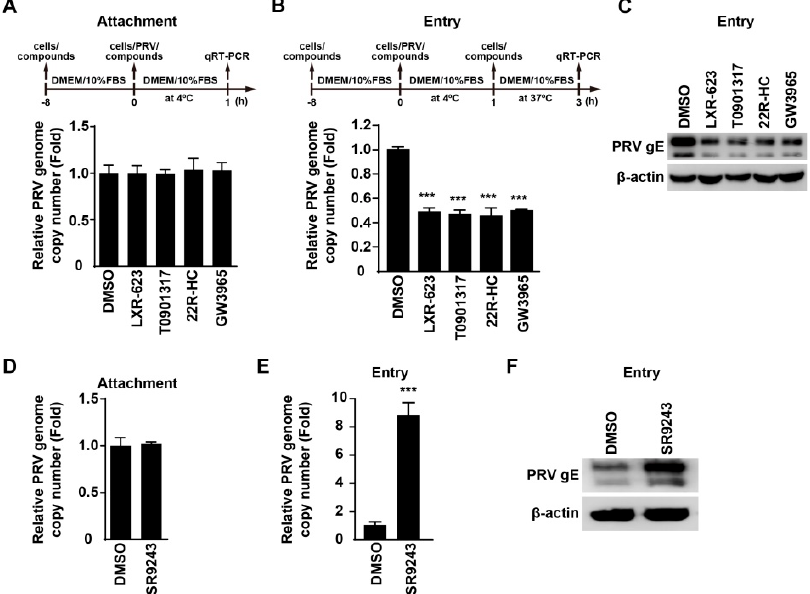
Figure 4. Activation of LXR inhibits PRV entry. ( A ) PK-15 cells were pretreated with DMSO, LXR-623 (6 µ M), T0901317 (6 µ M), 22R-HC (6 µ M) and GW3965 (3 µ M) for 8 h at 37 ◦ C. Cells were incubated with PRV-QXX (MOI = 0.1) combined with DMSO, LXR-623 (6 µ M), T0901317 (6 µ M), 22R-HC (6 µ M), and GW3965 (3 µ M) for 1 h at 4 ◦ C. After three washes with ice-cold PBS, the viral genome was isolated. PRV genome copy numbers on cells were assessed by qRT-PCR analysis. ( B ) PK-15